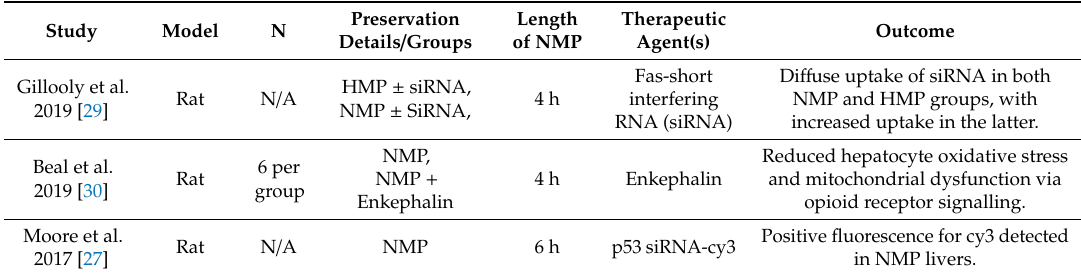
Table 1. Ischaemia Reperfusion